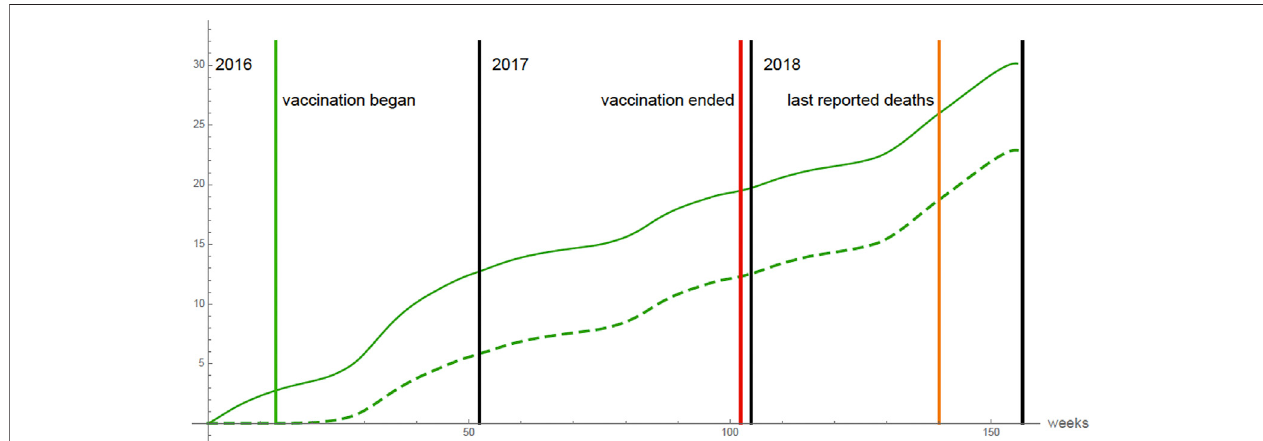
FIGURE 6 | All 875,000 9 years olds are vaccinated. The cumulative number of all deaths each week of the 875,000 vaccinated 9 years olds in 2016, 2017, 2018 (top graph) , and the vaccinated 9 years olds, who were not infected before vaccination, and became infected after vaccination as a result of vaccine failure (bottom graph) .